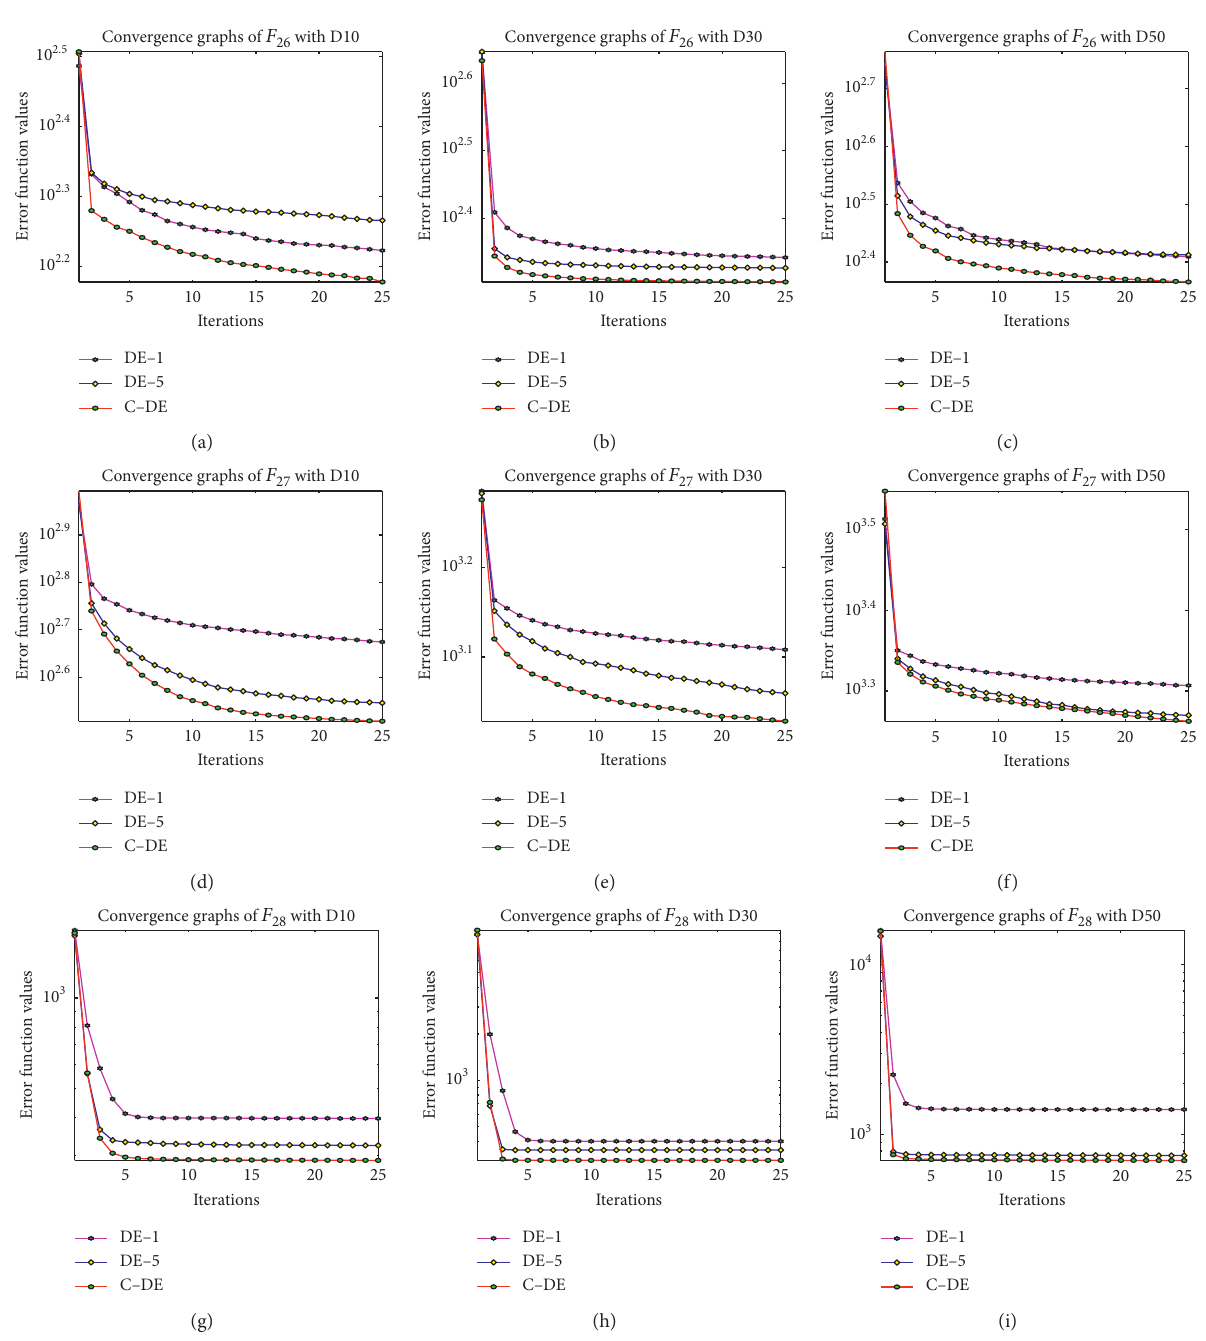
Figure 7: Evolution in the best function values of F